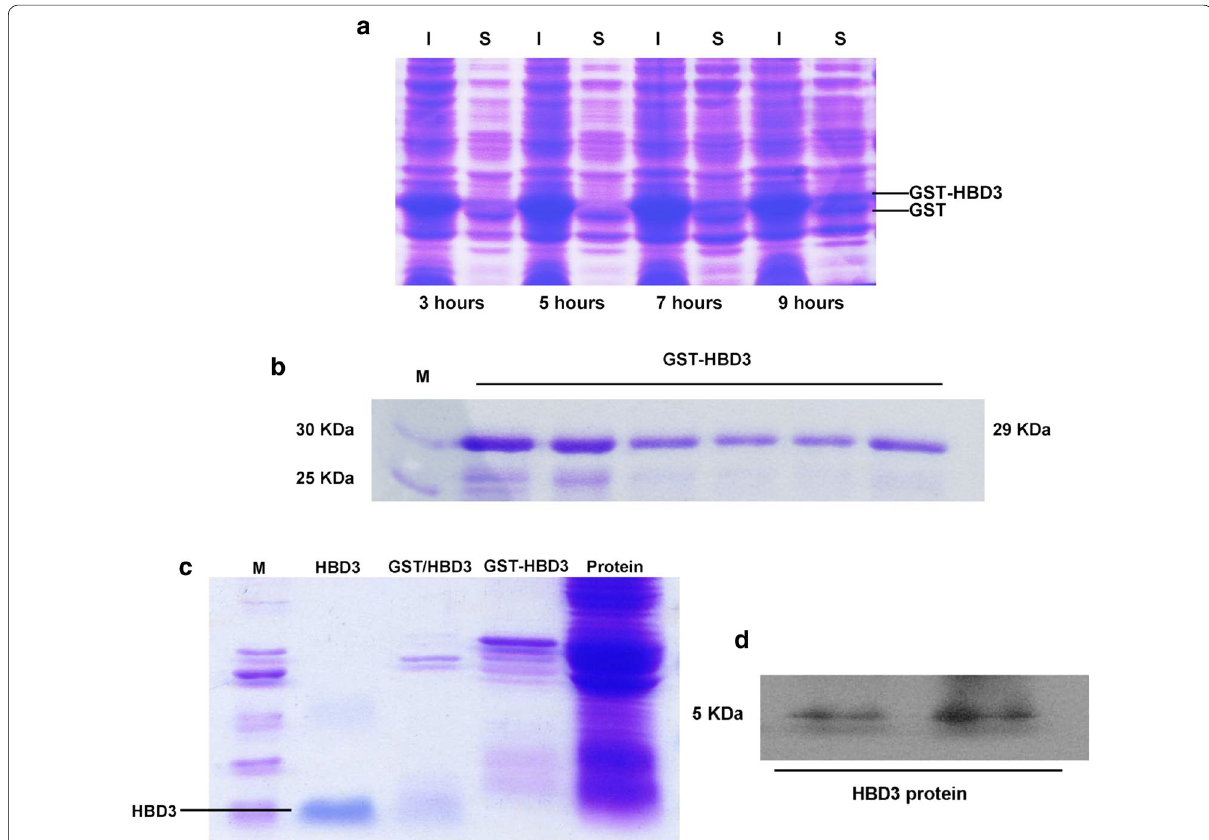
Fig. 2 Expression and identification of rHBD3 protein. a Effects of different post induction times on the expression of target fusion protein with BL21 (DE3) pGEX-5X-HBD3. Soluble and insoluble proteins were analyzed at various post induction times by using SDS-PAGE ( S soluble fractions, I insoluble fractions). b SDS-PAGE analysis of collected samples of purified fusion protein. M is the protein marker. Lanes are all the purified fusion protein. c SDS-PAGE analysis of protein fragment that has been digested by Factor Xa . M is the protein marker. Lane 1 is the purified recombination HBD3, lane 2 is the digested protein fragments lane 3 is pure GST-HBD3 protein, lane 4 is all protein. d Western blot analysis of recombination HBD3. Lanes are all the purified